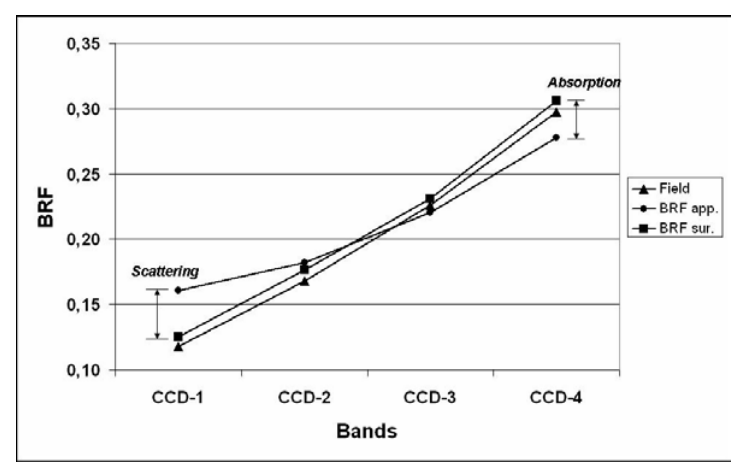
Fig. 2 – Spectral characterization of the reference surface 2 resulted from field data (Field), apparent BRF (BRF app.) and surface BRF (BRF